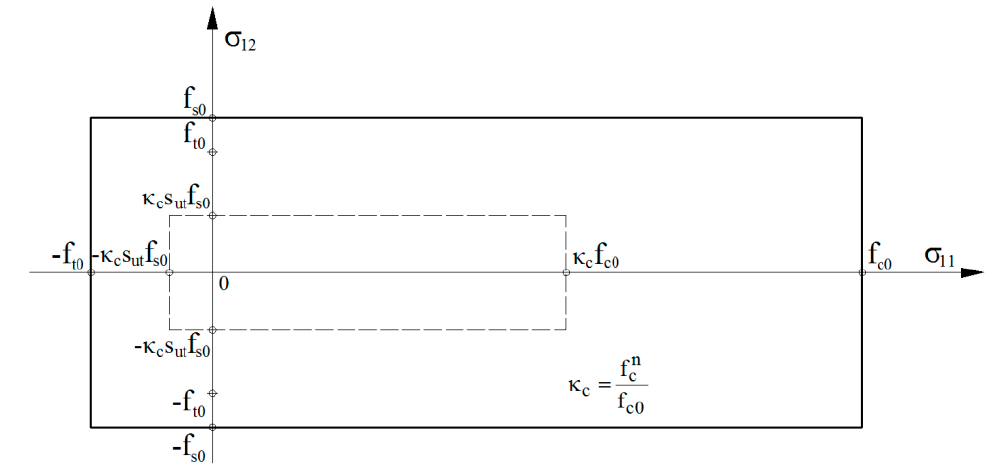
Figure 3. Limit curve for the plane stress state.